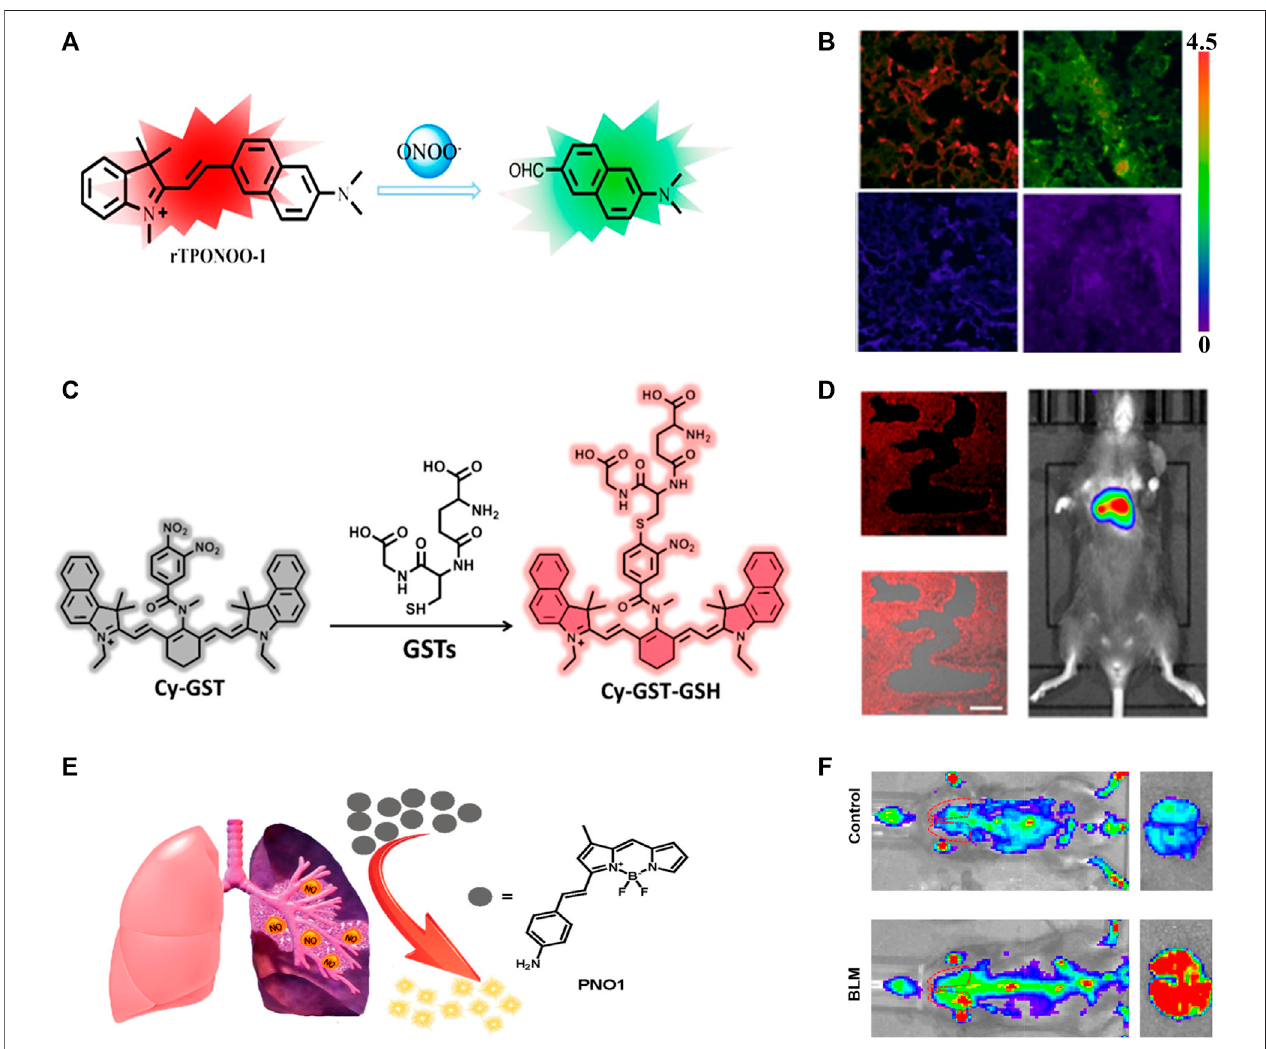
FIGURE 2 | (A) Detection mechanism of probe rTPONOO-1 to ONOO − . (B) Imaging of ONOO − levels from healthy lung slices to lung in fl ammation and pulmonary fi brosis. (C) Proposed Detection Mechanism of the Probe Cy-GST against GSTs. (D) The GST concentration of PF mice at 28 days of bleomycin stimulation, and the fl uorescence imaging and merged imaging of fl uorescence and bright- fi eld imaging of lung slices by treatment with Cy-GST. (E) Schematic illustration of the sensitive detection of NO by the fl uorescent probe PNO1. (F) Representative images of control or bleomycin mice, and the lungs isolated from indicated groups. Adapted and modi fi ed with permission from ref(He et al.,2019)(Copyright2019AmericanChemical Society), ref(Zhan et al.,2019) (Copyright2019AmericanChemical Society) and ref (Dong et al., 2020) (Copyright 2019 American Chemical